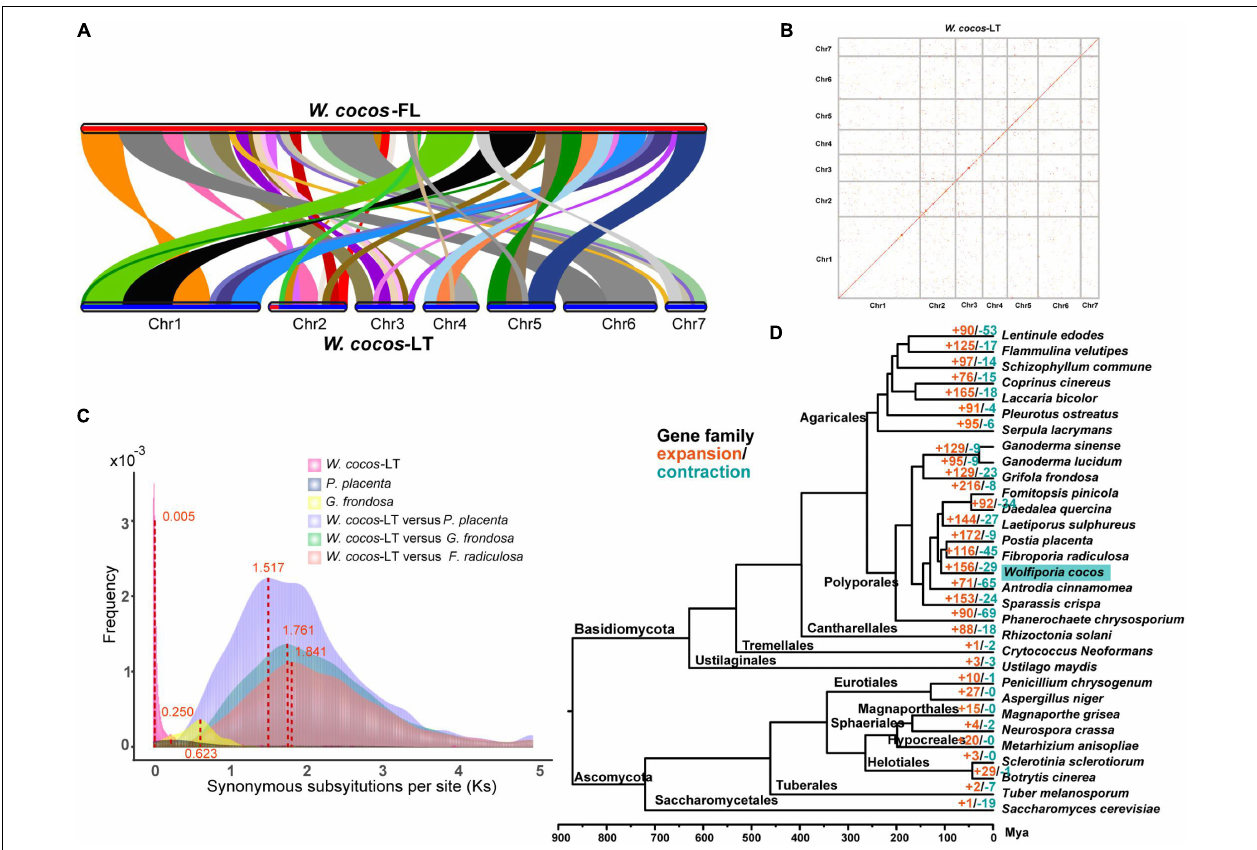
FIGURE 3 | Comparative genomics analysis of Wolfiporia cocos and other fungi. (A) A colinear block comparison between WCLT and WCFL genomes. (B) The synteny plot within the WCLT haploid genome. The red dots indicate potential homology between genes. (C) Synonymous nucleotide substitutions (Ks) among a homologous gene pair, showing Ks distribution within and between genomes. The probability density of Ks was estimated by the “density” function in the R language. (D) A phylogenetic tree of 31 fungi. A total of 210 single-copy genes of 31 fungi species were selected to construct the phylogenetic tree. The red and green color numbers, respectively, represent the number of gene families that expand and contract. Due to lack of fossil data to estimate the specific time, the divergence times were estimated according to the fungal divergence time provided by the TimeTree website (www.timetree.org). Mya, million years